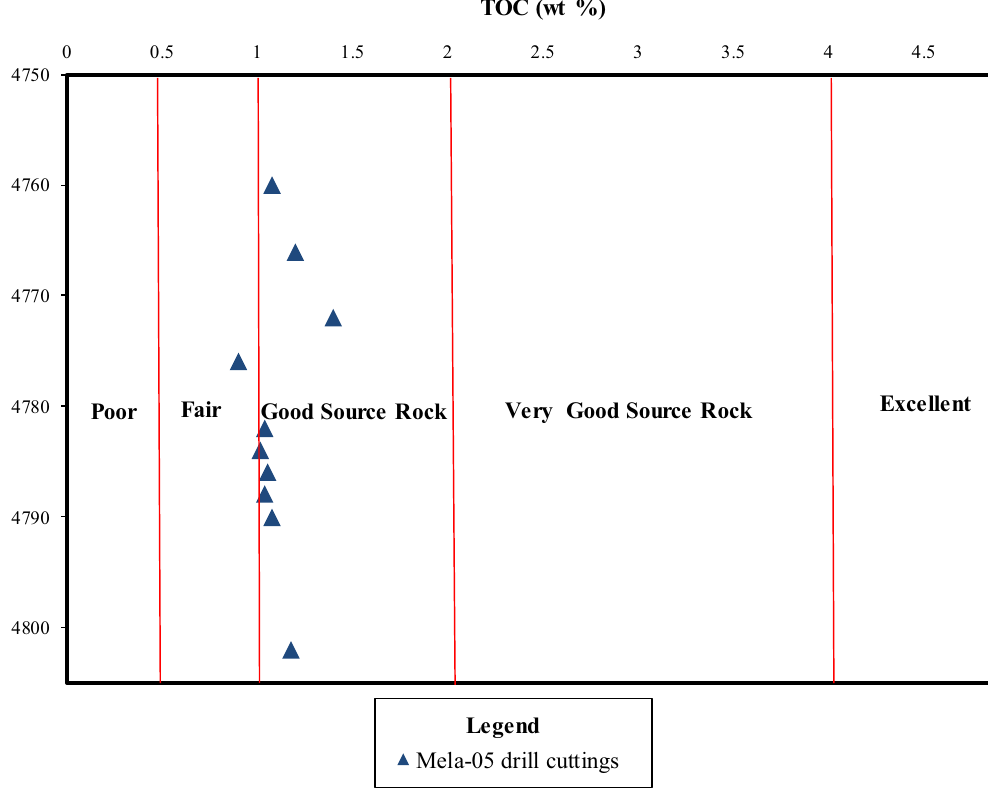
Table 4 Rock–Eval pyrolysis results of the Chichali Formation from Mela-05